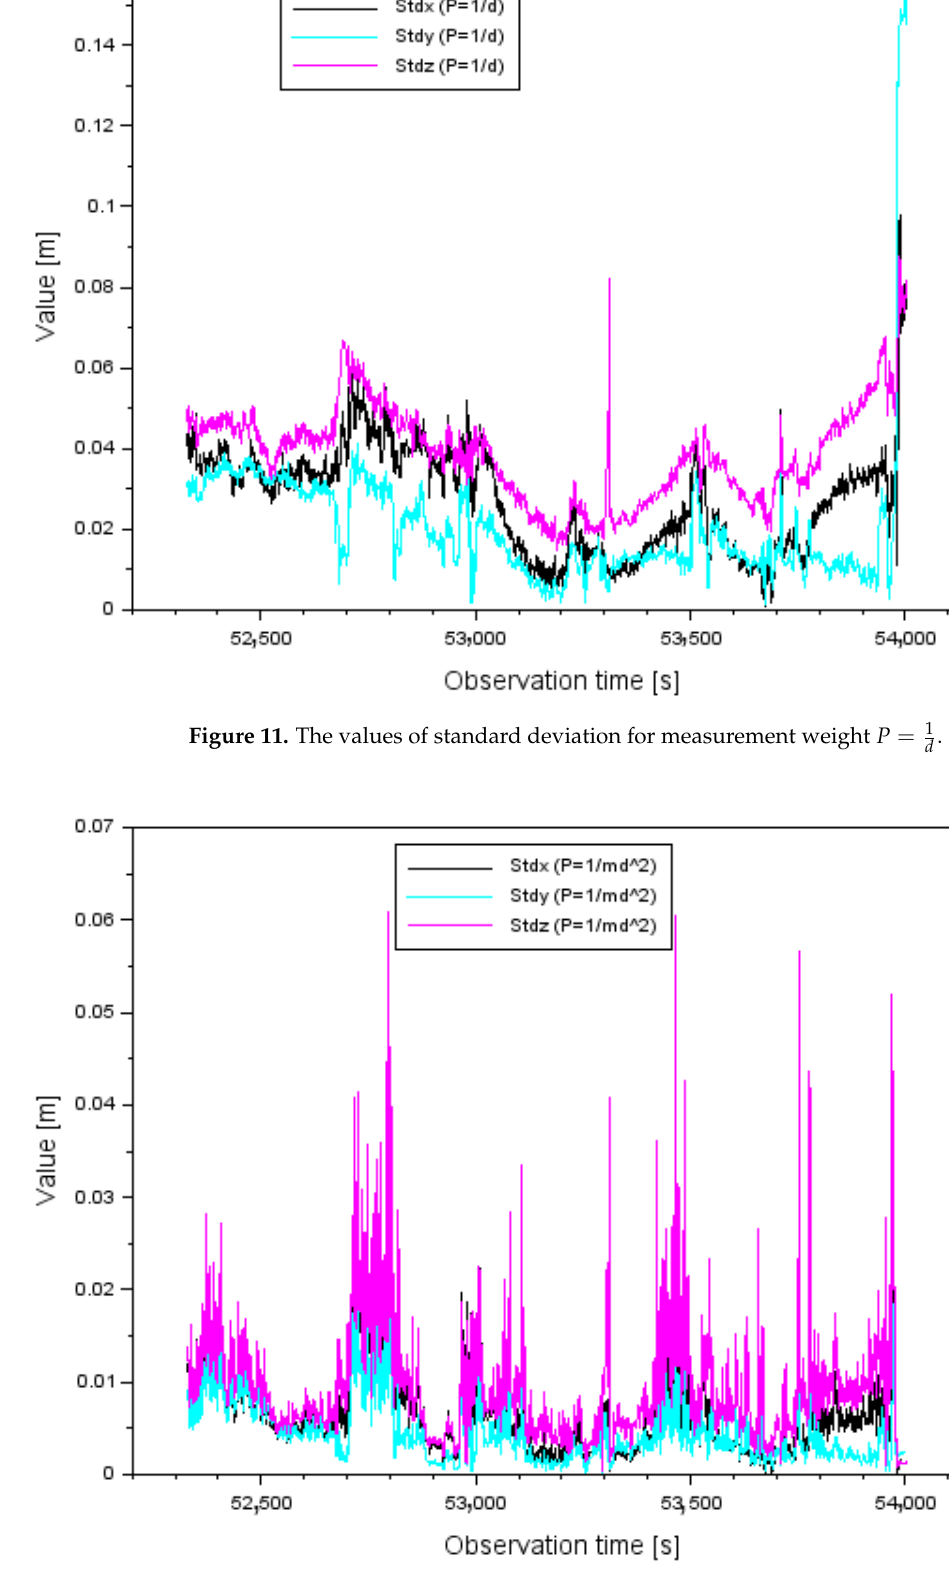
Figure 12. The values of standard deviation for measurement weight P = 1